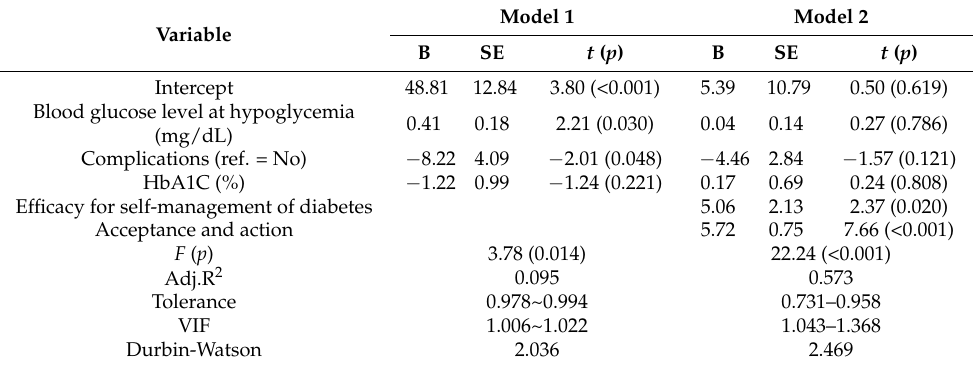
Table 5. Influencing Factors on QOL ( N =